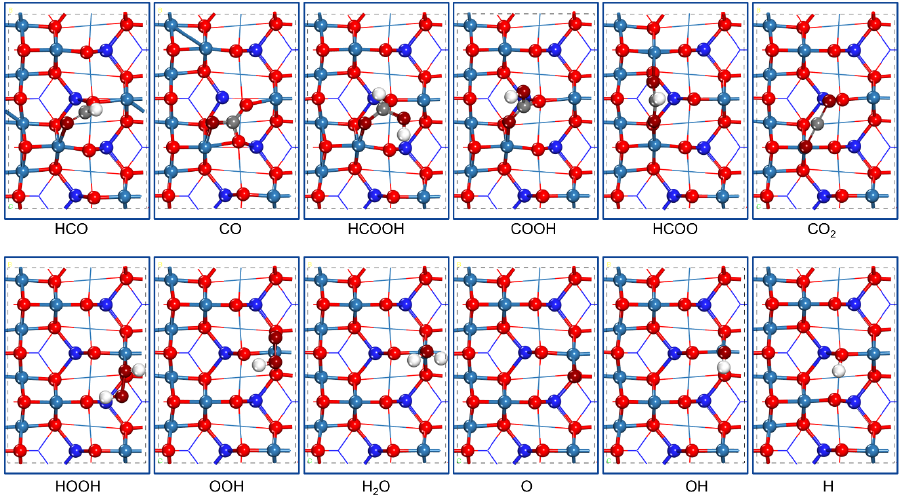
Figure 3. The most stable adsorption configurations of possible intermediate species involved in HCHO oxidation to CO 2 and H 2 O on Co 3 O 4 (110) surface.